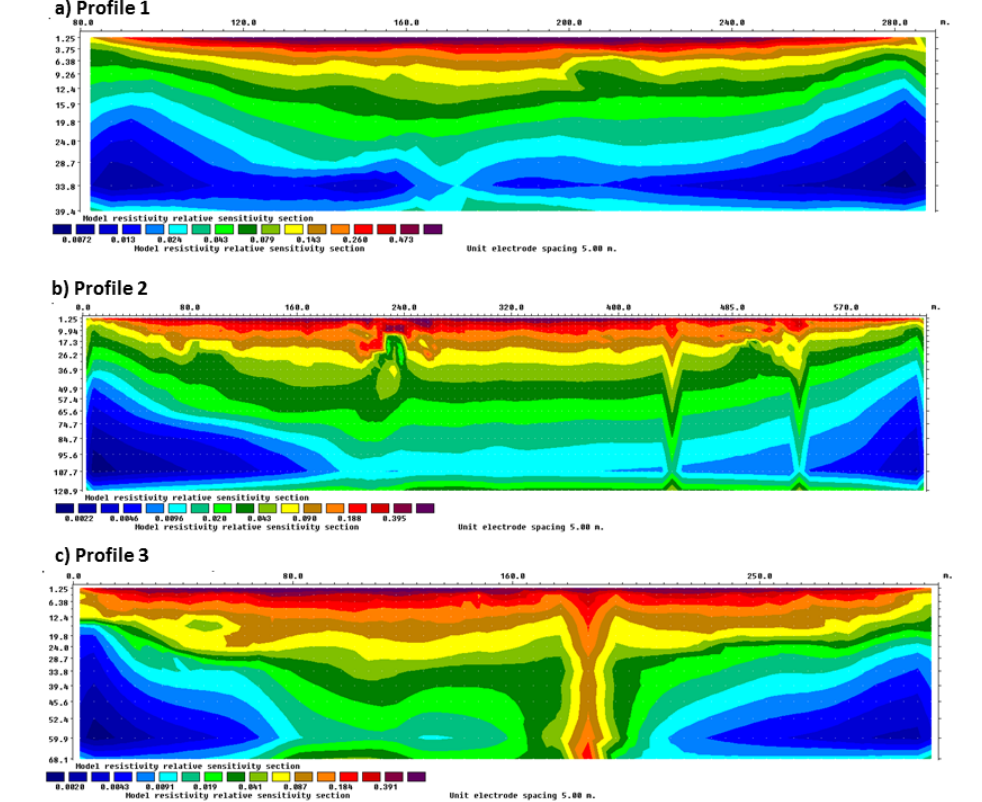
Figure A1. Normalized sensitivity distribution associated with the ERT/TDIP Profiles 1, 2 and